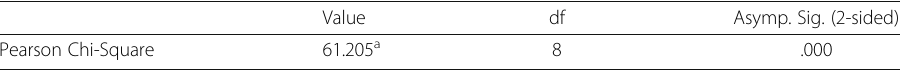
Table 7 Explicit grammar instruction and corrective feedback by proficiency levels Value df Asymp. Sig. (2-sided) Pearson Chi-Square 61.205 a 8 .000